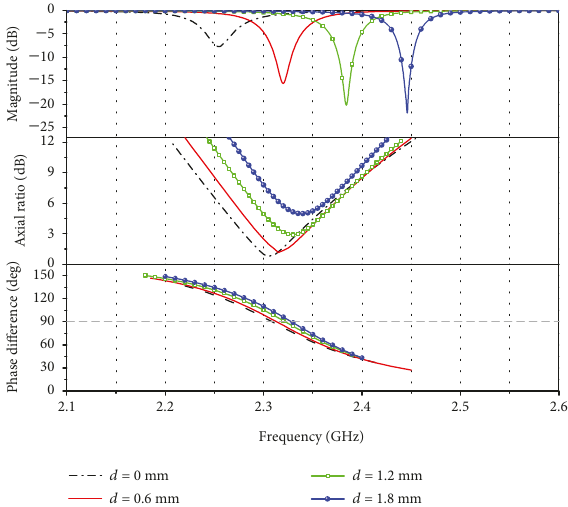
Figure 4: Simulated results of the proposed antenna with di ff erent positions d : re fl ection coe ffi cient, AR, and phase di ff erence between two resonant frequencies.